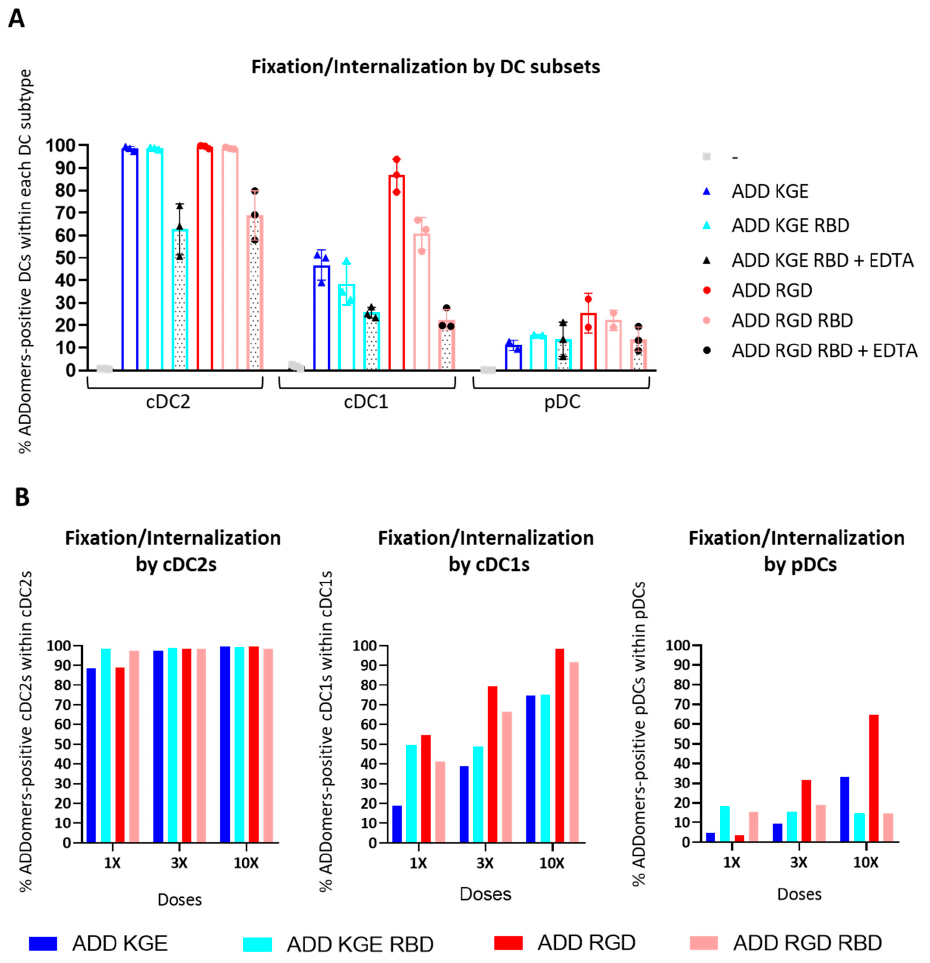
Figure 8. ADD KGE/RGD (with or without RBD-SC and EDTA) fixation/internalization by DC subsets. PBMC pre-incubated or not with EDTA were incubated with fluorescent KGE/RBD AD- Domer for 1 h. The fixation of ADDomer by DC subsets was then evaluated by flow cytometry. ( A ) Fixation and internalization evaluation of ADD KGE/RGD (with or without RBD-SC and EDTA) (0.5 µ M i.e., 3 × ) on DC subsets using flow cytometry ( n = 3 donors). ( B ) Fixation and internalization evaluation of ADD KGE/RGD (with or without RBD-SC and EDTA) (0.15 µ M i.e., 1 × or 0.5 µ M i.e., 3 × or 1.5 µ M i.e., 10 × ) on DC subsets using flow cytometry ( n = 1